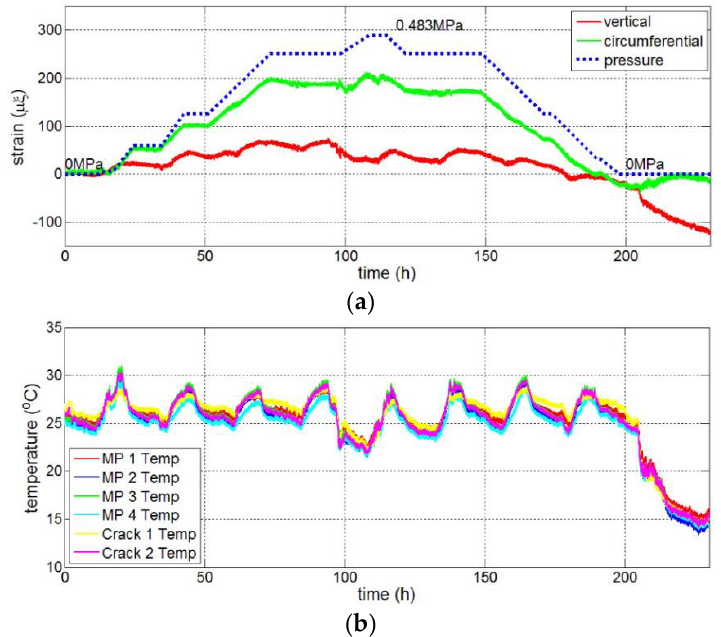
Figure 8. Comparison between the strain of MP 1 and measured temperature. ( a ) MP 1; ( b ) Temperature of each measure point.